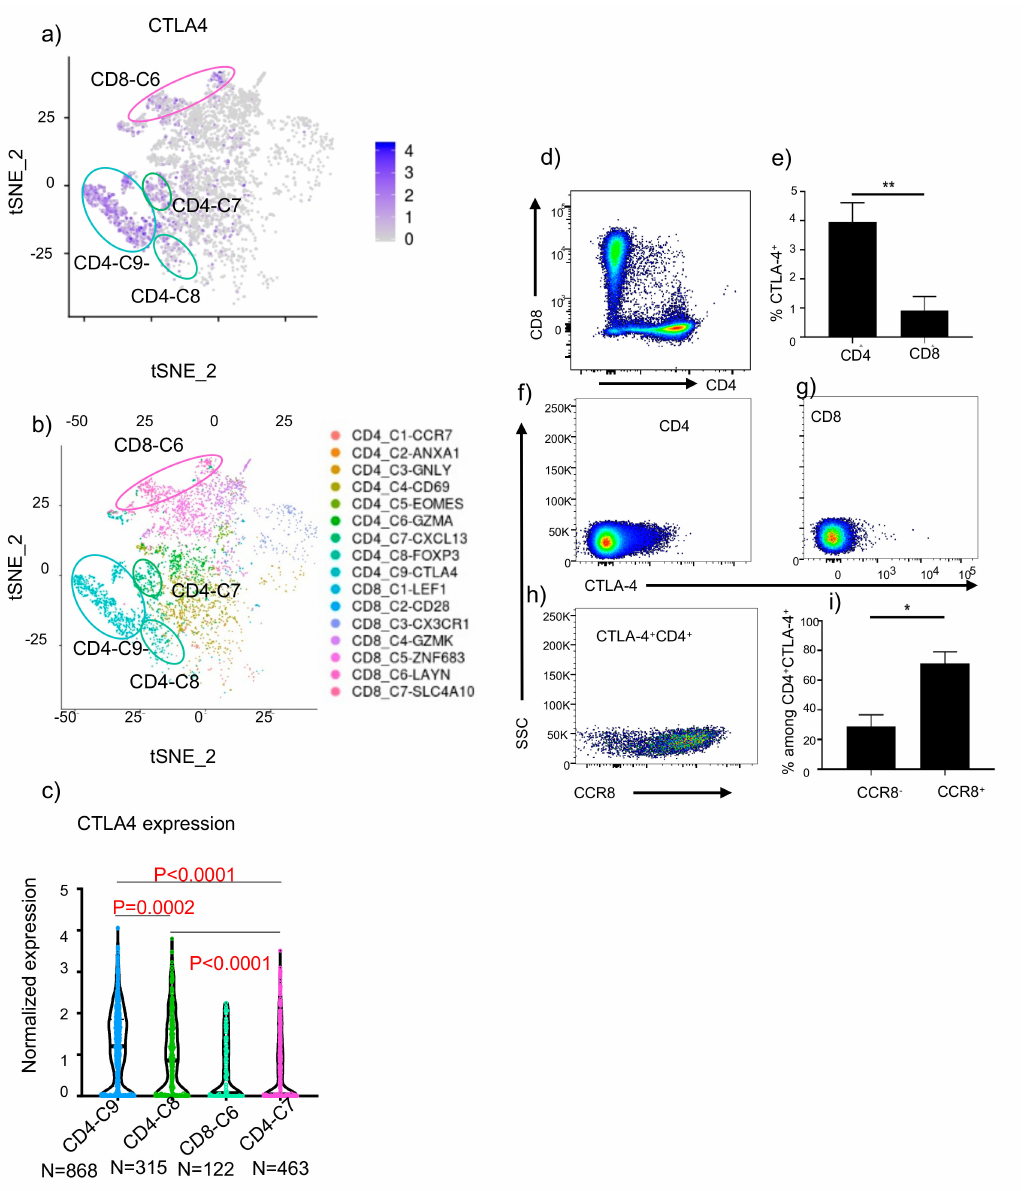
Figure 6. Predicting selectivity of anti-CTLA-4 mAb-mediated Treg depletion in human NSCLC. ( a ) The CTLA 4 transcript levels among tumor-infiltrating T lymphocytes, using data from the database byGuoetal.[36]( b ) CTLA 4expressionamonghumanTlymphocytesclassifiedbyGuoetal.[36]( c )Violin plot showing the single cell expression pattern of the CTLA 4 across four indicated clusters. Statistical significance was determined by the One-way ANOVA. ( d ). CD4 / CD8 subsets among tumor-infiltrating cells in NSCLC samples. ( e – g ) Expression of CTLA-4 among CD4 and CD8 cells. Summary data from 9 cases ( e ) and representative profiles ( f – g ) from 1 / 9 cases are presented. ( h ) Representative profiles of CCR8 and CTLA-4 distribution among tumor infiltrating CD4 T cells. ( i ) Summary data showing the distribution of CCR8 + vs. CCR8 − cells among CTLA-4-expressing